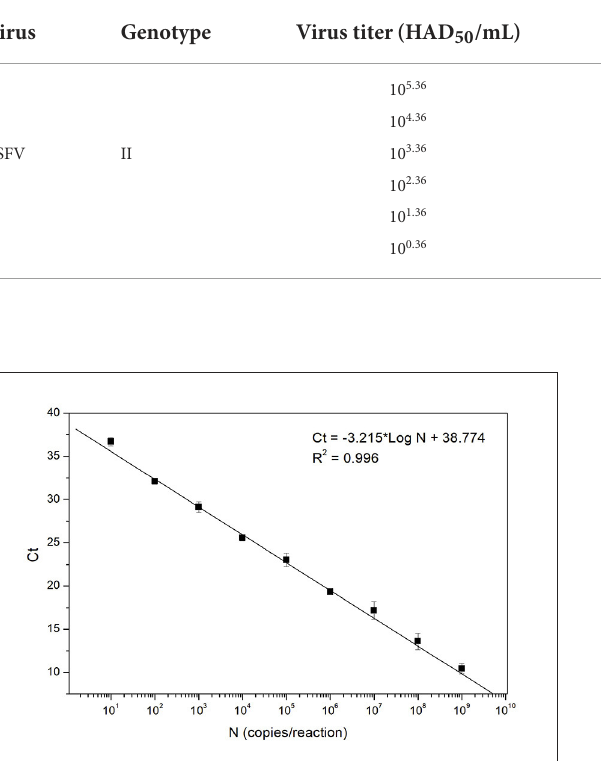
FIGURE2 Standard curve of the fast ASFV PCR assay. The curve was generated by analyzing triplicate of 9-fold serial dilutions of the standard sample template, ASFV DNA GT2. Each data point (filled square) corresponds to the mean Ct value of the three replicates at each concentration.